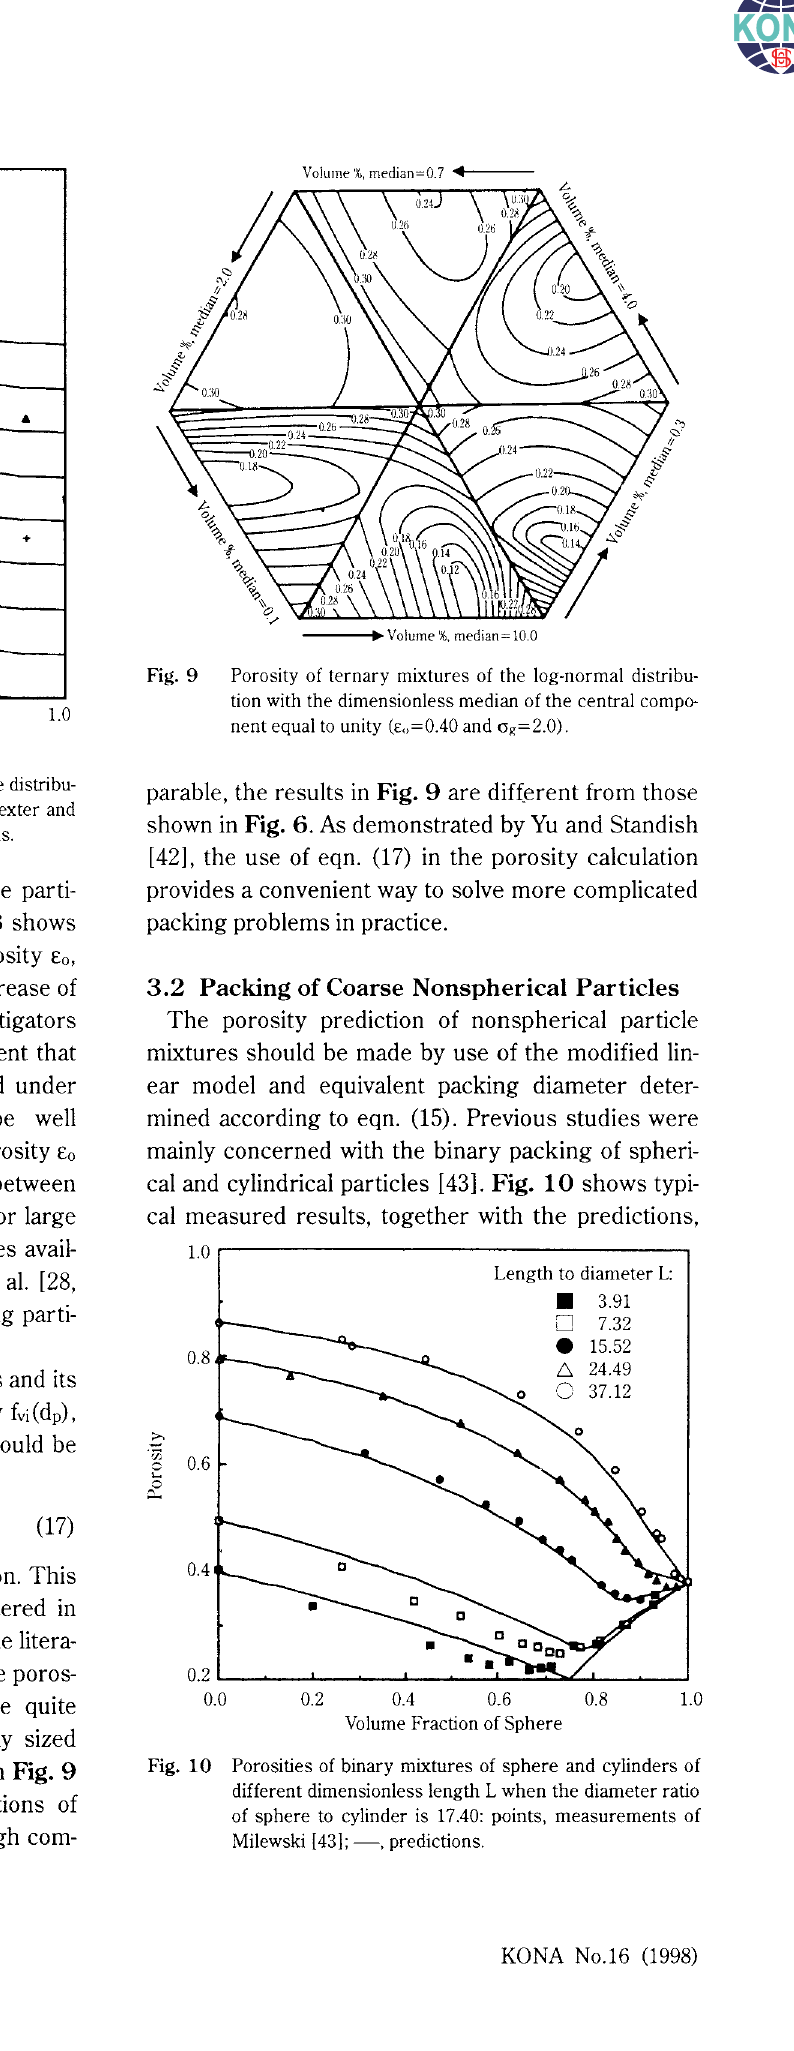
Fig. 10 Porosities of binary mixtures of sphere and cylinders of different dimensionless length L when the diameter ratio of sphere to cylinder is 17.40: points, measurements of Milewski [43];